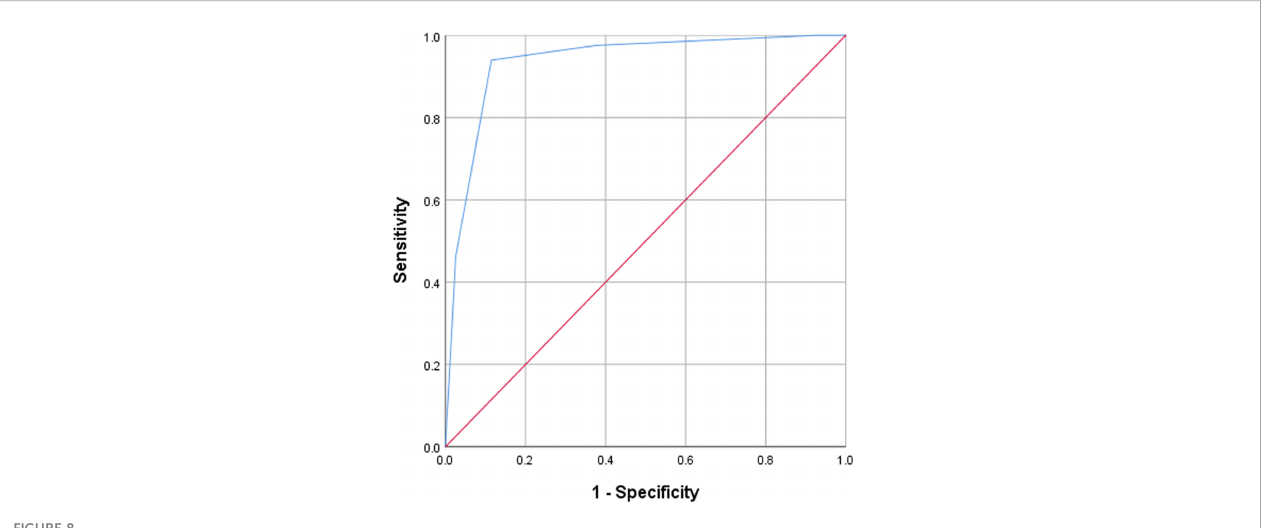
FIGURE 8 ROC analyses for the diagnostic performance of the modi fi ed version of the TI-RADS for predicting the malignancy of thyroid nodules. The best cut-off was > TIRADS 4a, resulting in 93.6% SEN and 88.5% SPN.